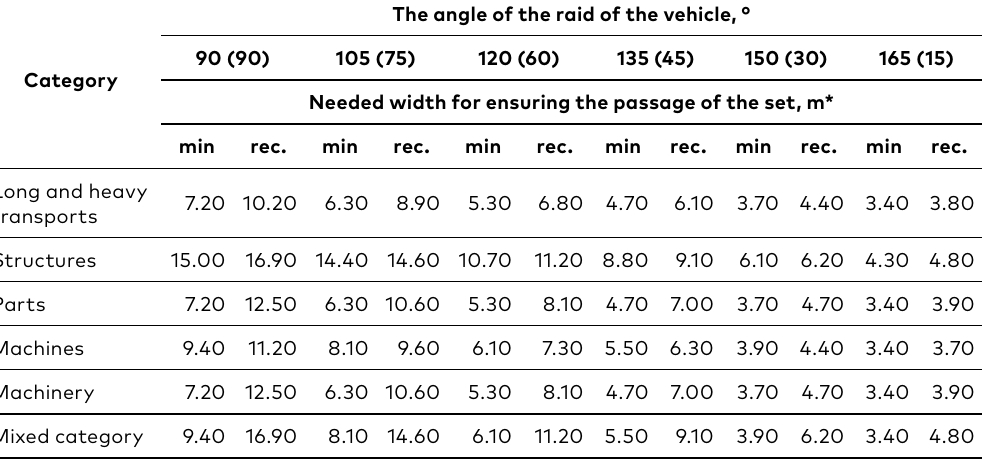
Table 4. Results of the values of width of the